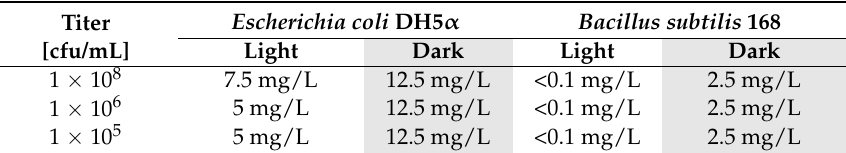
Table 3. MIC values of chlorophyllin converted from commercial chlorophyll, determined in light (bright columns) or darkness (grey